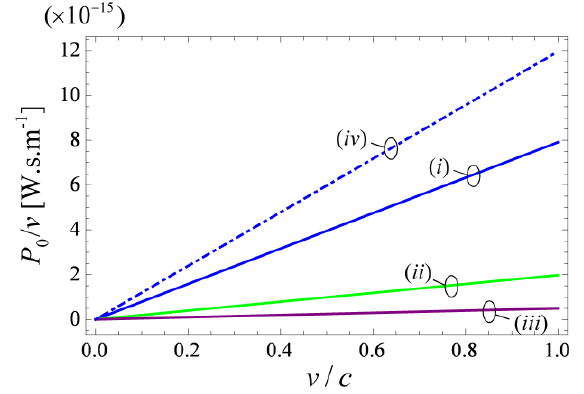
Figure 3. Stopping power ( / P v ) as a function of the normalized velocity ( / v c ) for a 0 single charged particle moving inside the uniaxial wire medium (Figure 1b) formed by PEC wires, 1   , and different values of the lattice spacing a and radius of the wires h